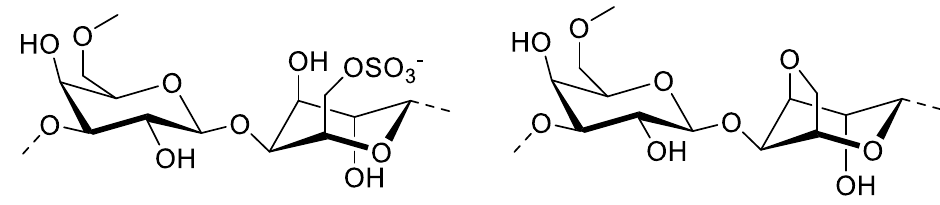
Figure 4. Chemical structure of the typical porphyran.